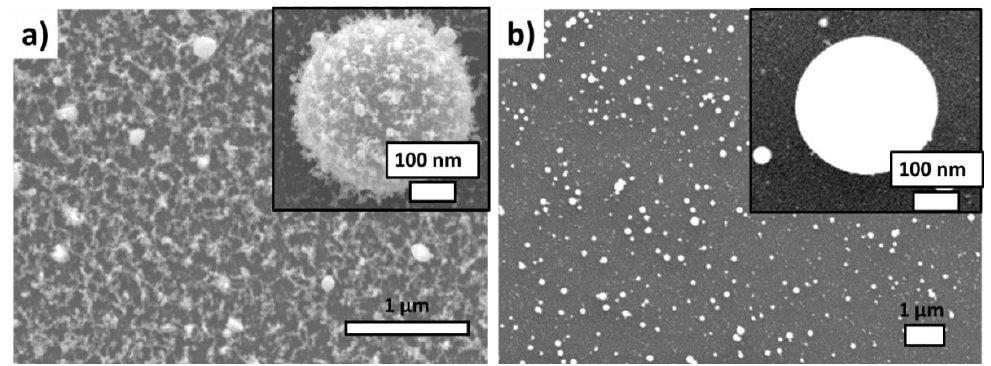
Figure 2. SEM visualization of Ag NPs laser-transferred onto the acceptor Si substrate: ( a ) from the donor polyethylene substrate, ( b ) from the donor silica glass substrate.